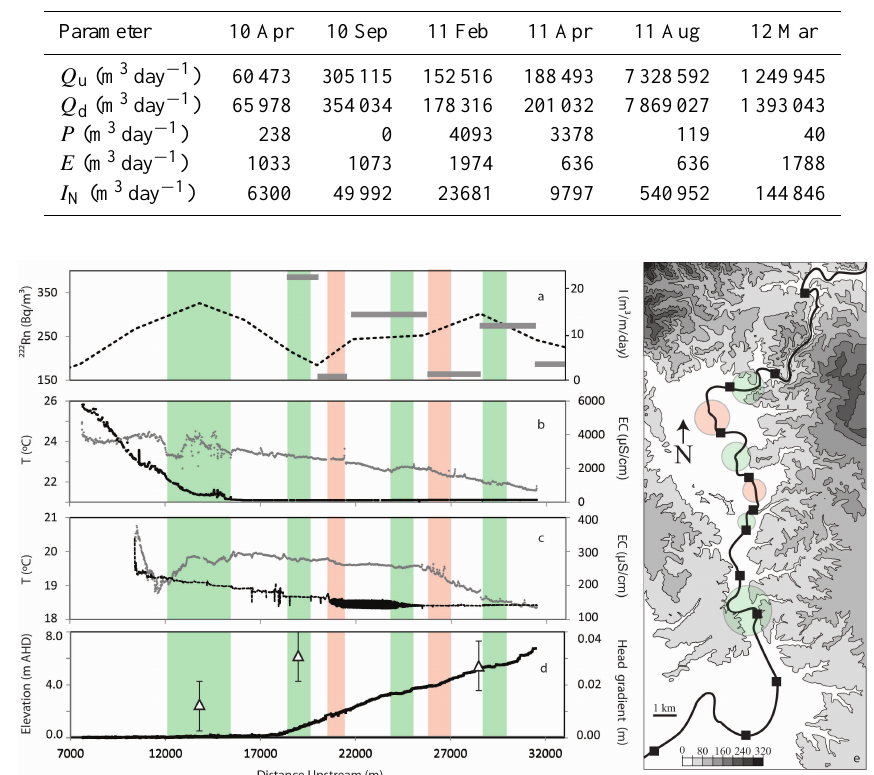
Fig. 5. Inferred zones of increased groundwater discharge (green shading) and decreased groundwater discharge (red shading) on the Tambo River as indicated by (a) average 222 Rn activities (dashed line) and average groundwater fluxes by 222 Rn mass balance (grey bars), tem- perature (grey dots) and EC (black dots) profiles from February 2011 (b) and March 2012 (c) , average groundwater–surface water gradients (triangles) surface water elevation (black line) (d) , and local topography (e) .